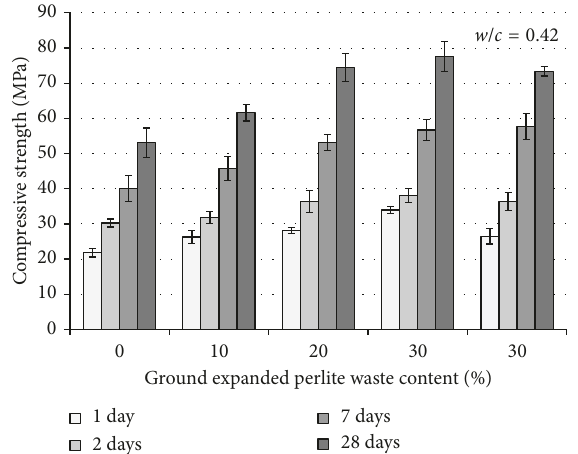
Figure 5: Compressive strength of pastes with ground expanded perlite waste addition.